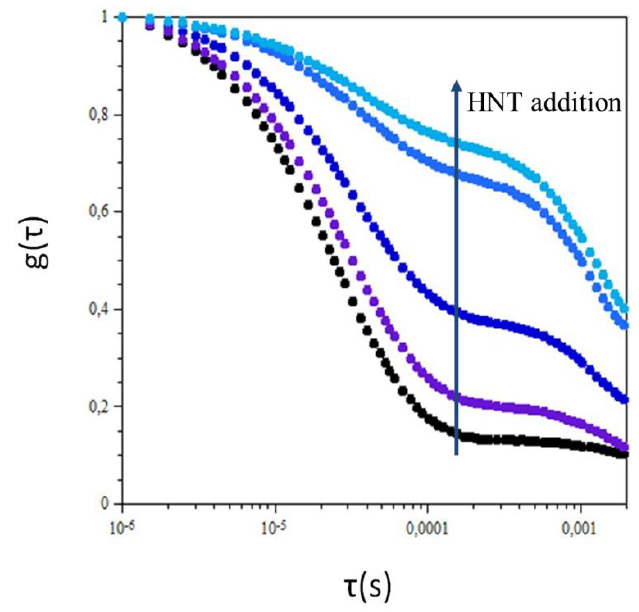
Figure 2. Autocorrelation function for halloysite nanotubes (HNTs) in microemulsion at 0.014% ( ● ), 0.0125% ( ● ), 0.005% ( ● ), 0.0025% ( ● ) e 0.0013% ( ● ).